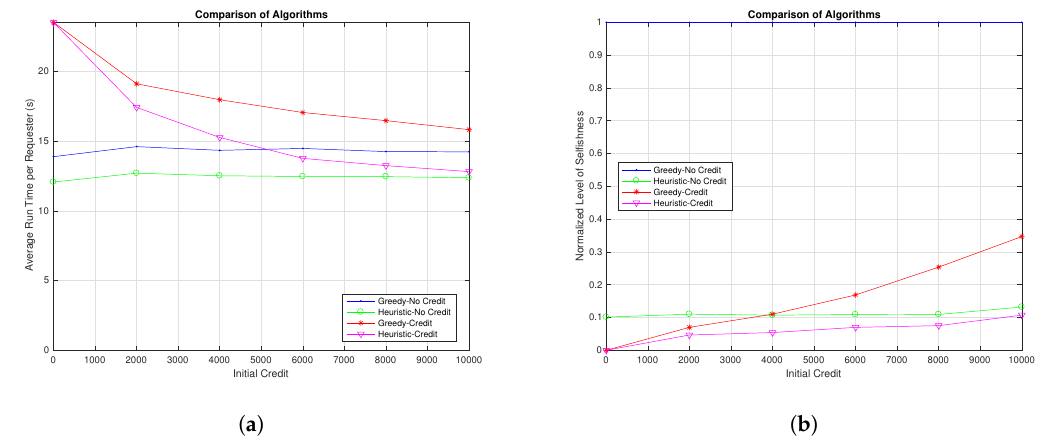
Figure 5. Effect of initial credit. ( a ) Effect on average task execution time; ( b ) effect on the level of